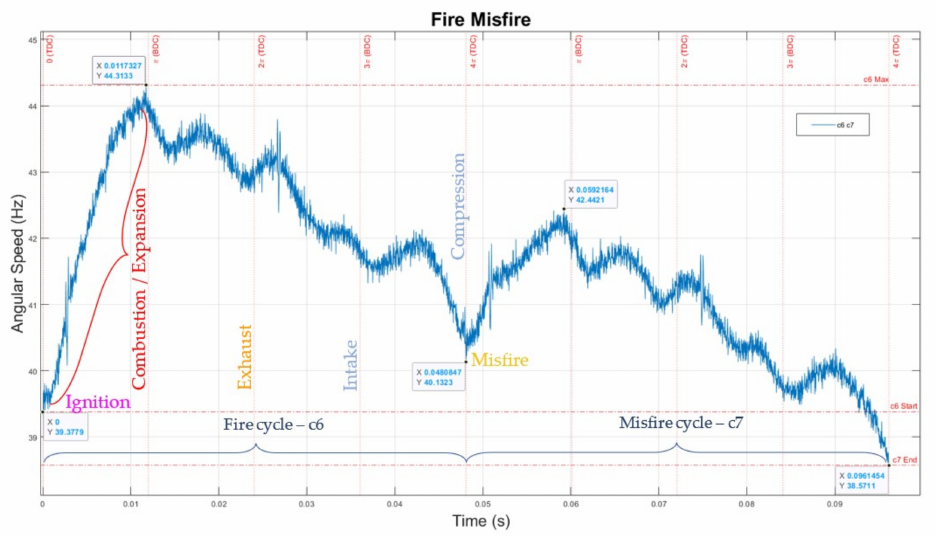
Figure 20. The engine in operation: c6—fire, and c7—misfire cycles.